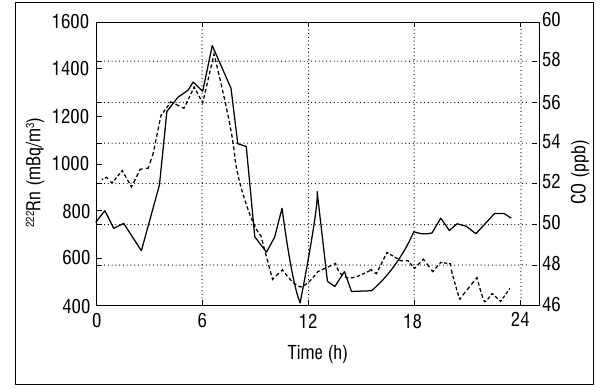
Figure 4: Diurnal distribution of CO (solid line) and 222 Rn (dashed line) observed at the Cape Point Global Atmosphere Watch station on 03 January